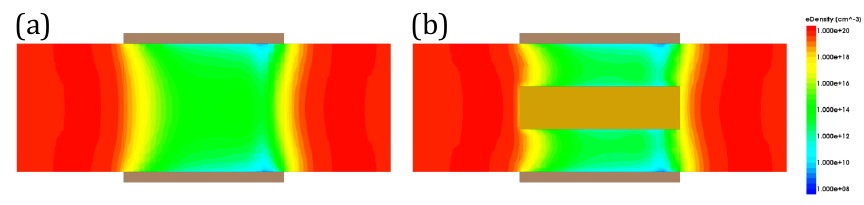
Figure 6. The electron density plot of CIGAA and GAA, the devices are at off state: ( a ) electron density of GAA; ( b ) electron density of CIGAA. Both figures are plotted when V GS = 0 V, V DS = 1 V. Metal gate and part structures are not included in the figure for clarity.